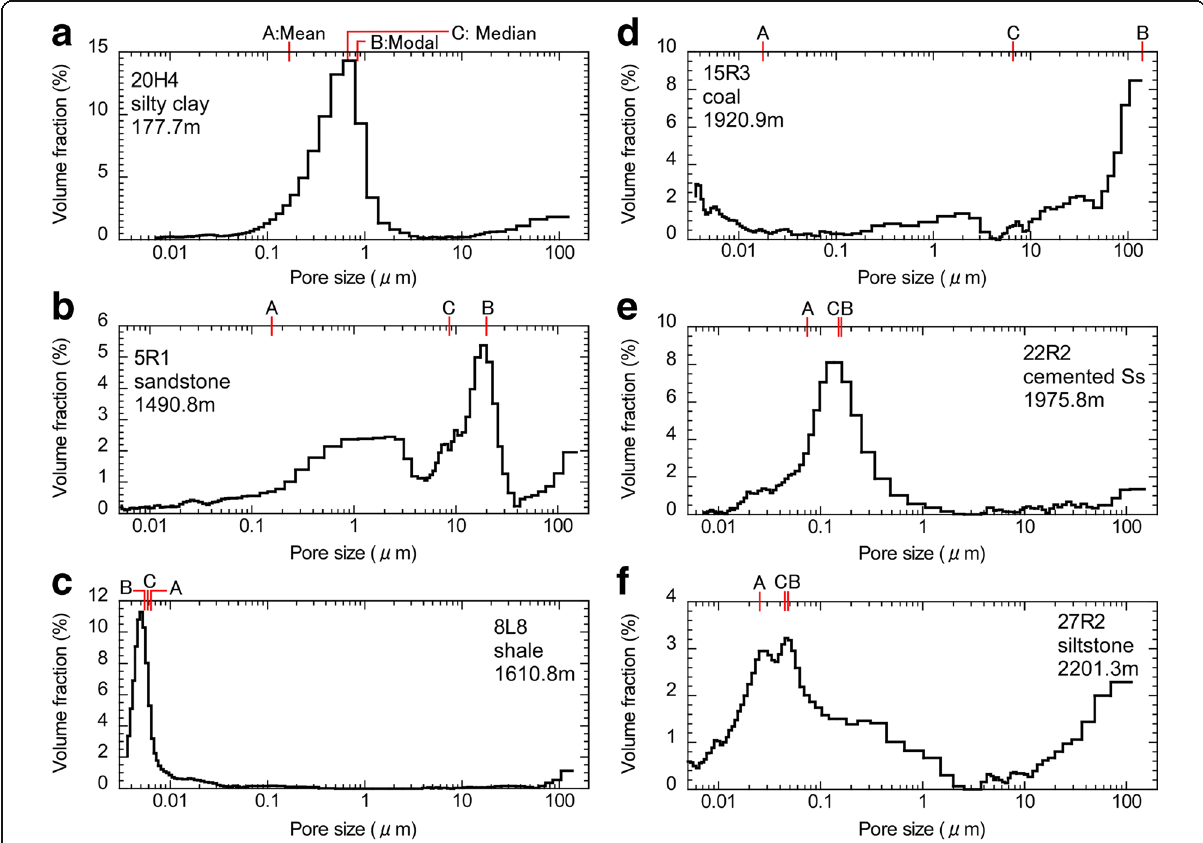
Fig. 3 Examples of pore size distribution for core samples at Site C0020. Mean ( a ), modal ( b ), and median ( c ) pore size distributions are plotted in the same figures: a silty clay at 177.7 mbsf, b sandstone at 1490.8 mbsf, c shale at 1610.8 mbsf, d coal at 1920 mbsf, e well-cemented sandstone at 1975.8 mbsf, and f siltstone at 2201.3